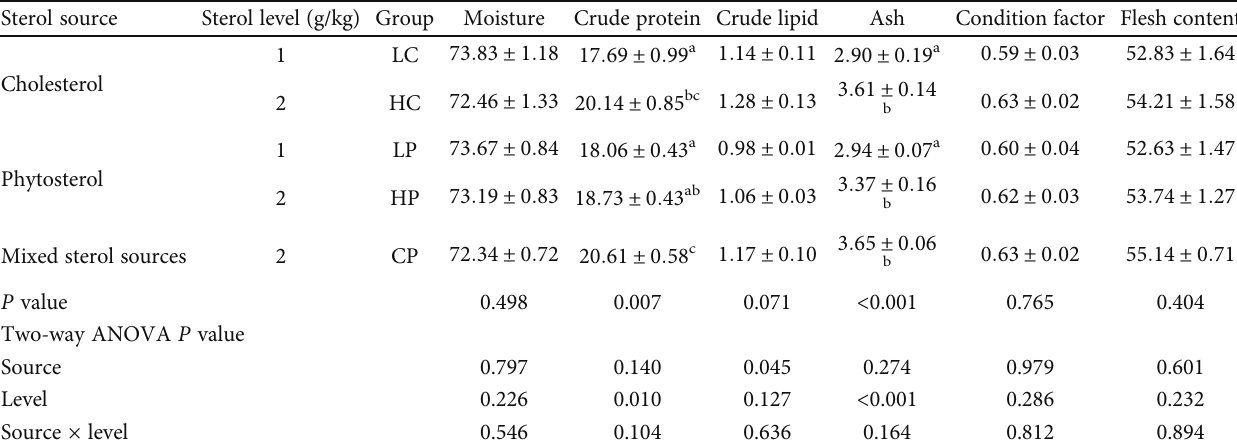
Table 3: Body composition and physical indicators of shrimp fed di ff erent